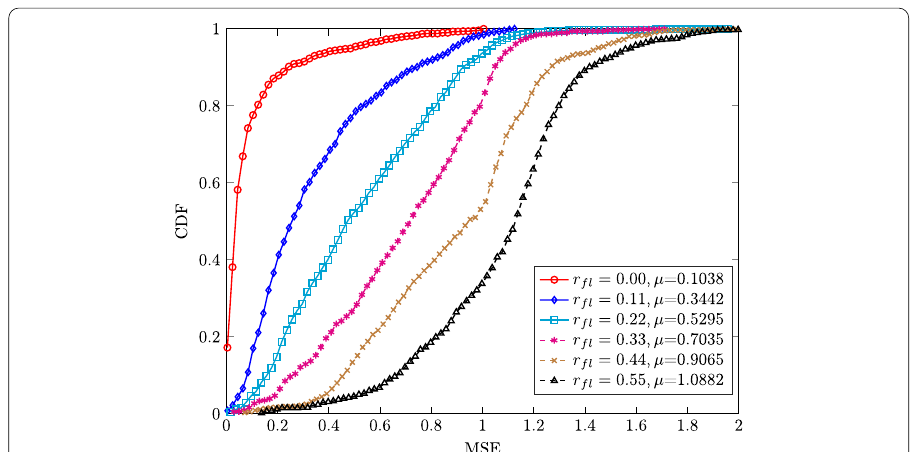
Fig. 11 Comparison of CDF of the SFB-CBH system in terms of MSE in time-variant channel. The cell-edge SNR is 10 dB . The µ values in the legend, shows the average value